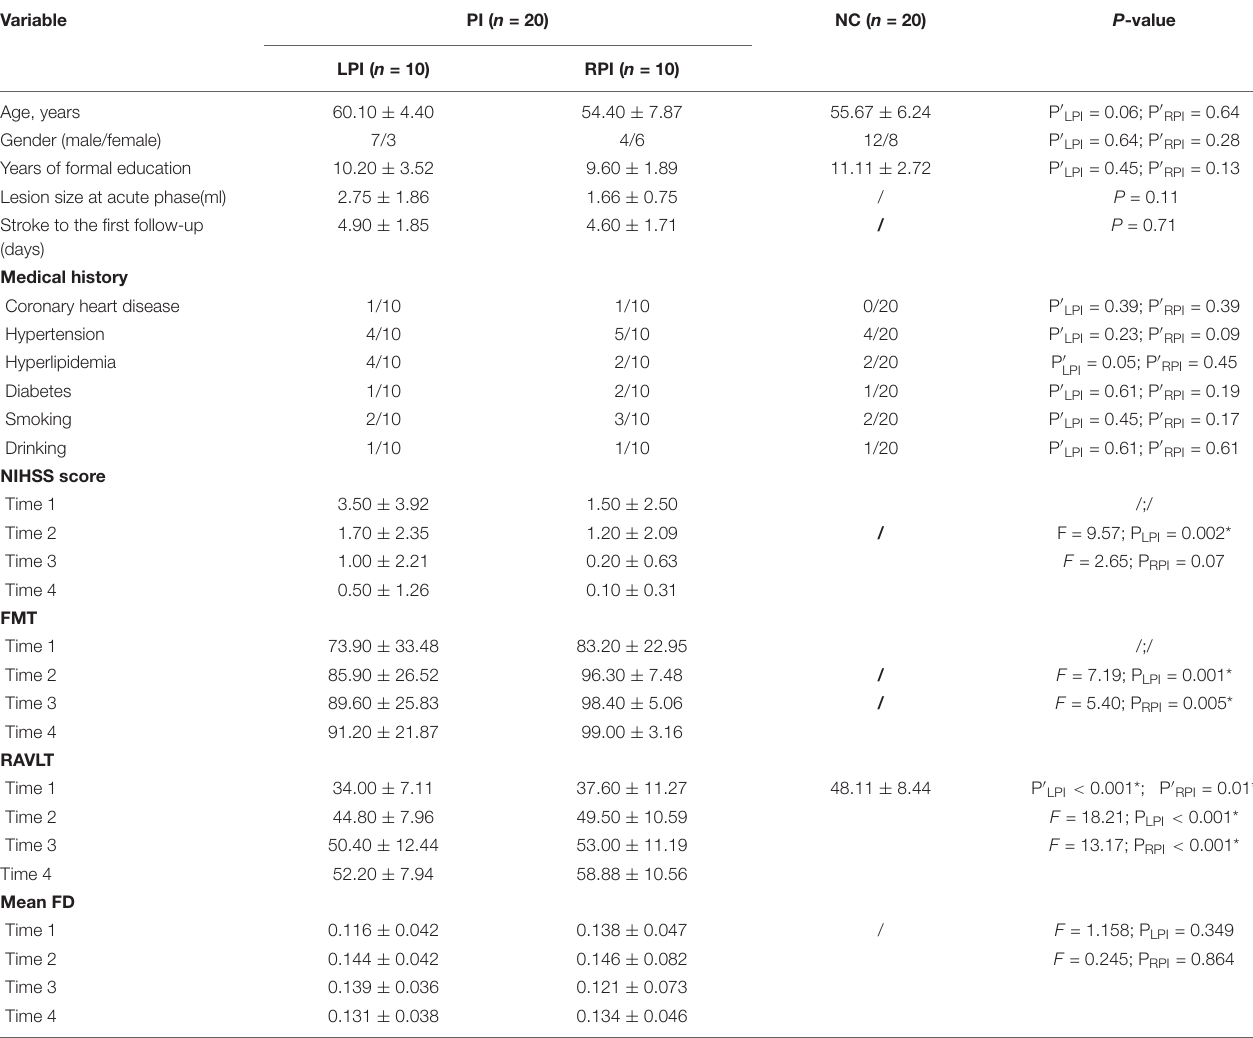
TABLE 1 | Demographic and clinical data in the PI and NC